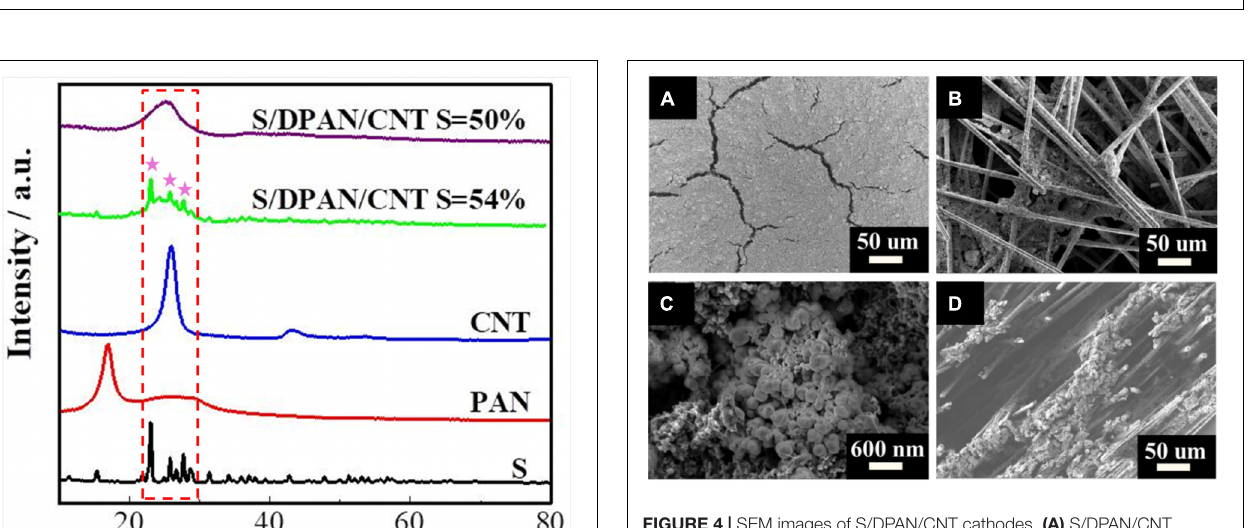
FIGURE 4 | SEM images of S/DPAN/CNT cathodes. (A) S/DPAN/CNT cathode on Al foil, (B,C) low and high magnification S/DPAN/CNT cathode on CFP current collector, and (D) cross-section view of S/DPAN/CNT cathode on CFP current